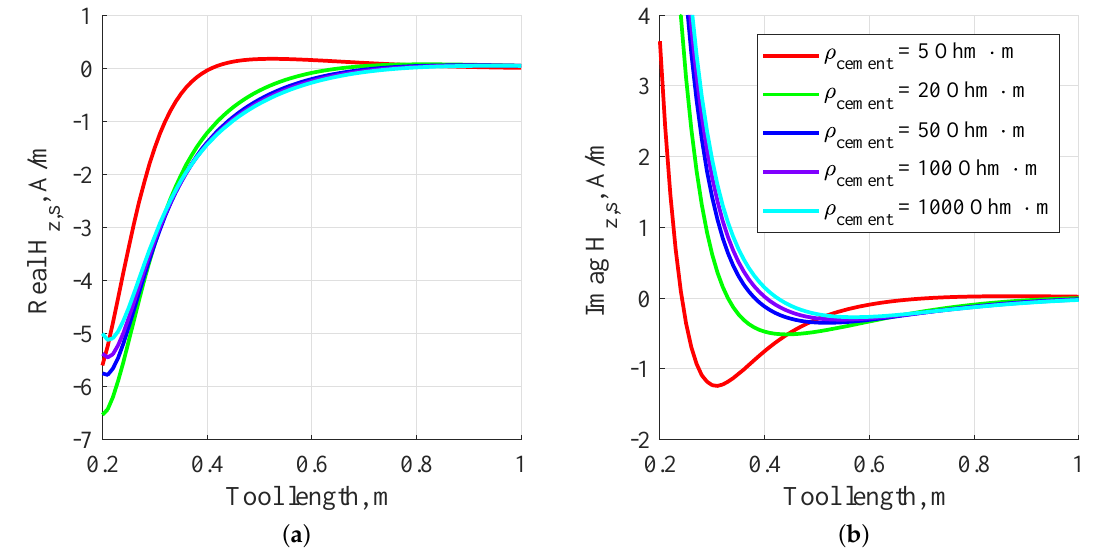
Figure 6. Intensity of ( a ) real and ( b ) imaginary part of H z , s vs. tool length at the frequency of 200 MHz. Different state of the cement is considered: The harder the cement, the higher the